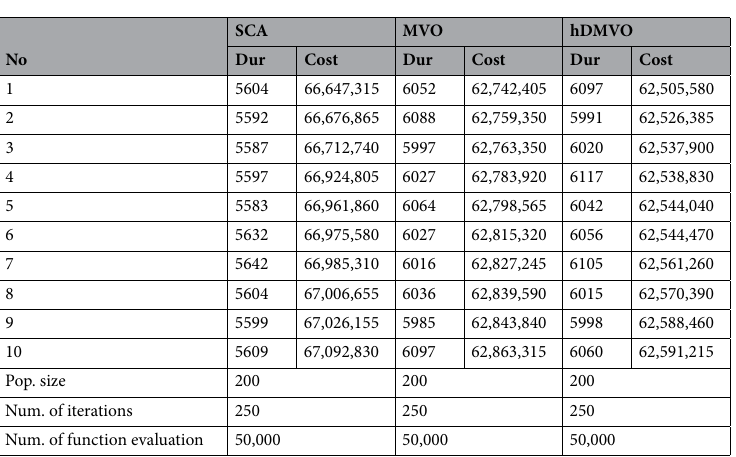
Table 13. Analysis results of problem